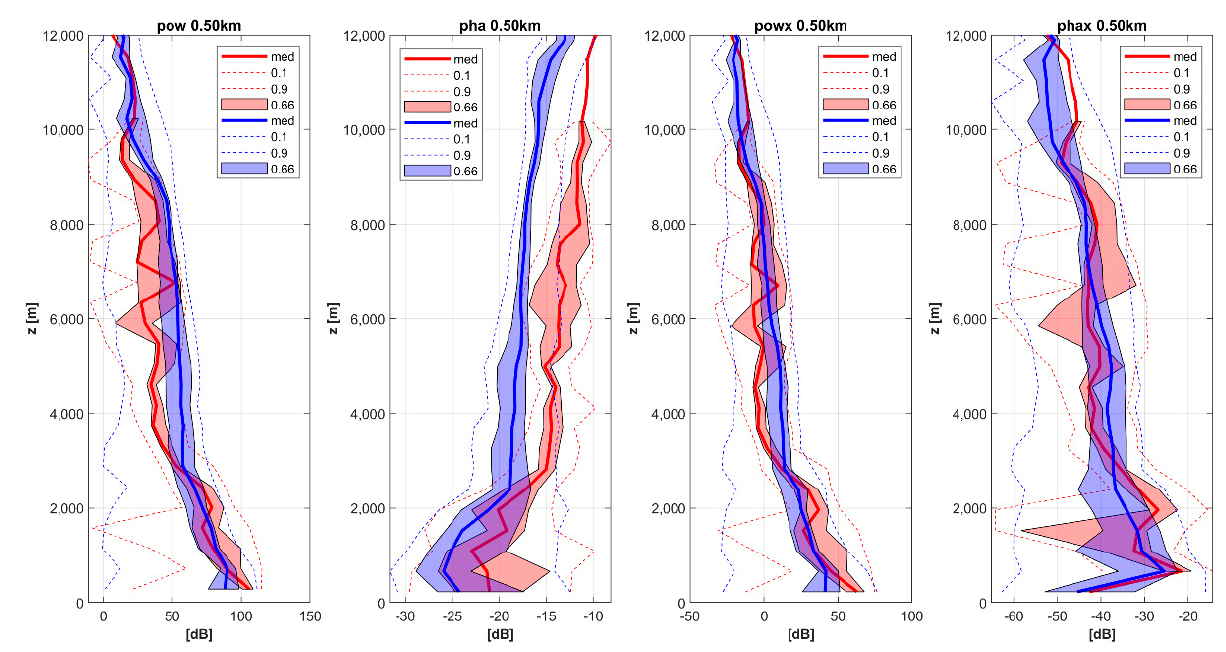
Figure 10. Comparison of statistical characteristics of pow, pha, powx and phax for “near(0.5 km)” and “far” data. Detailed figure caption is given in Figure 7. Both pha and phax are depicted using 10*log10(arctan) for better representation of vertical profiles of the data.